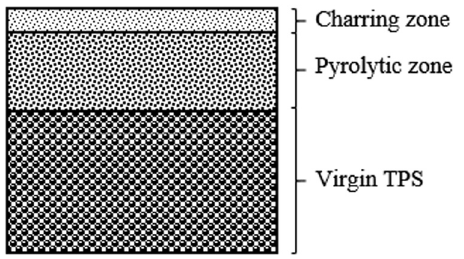
Figure 1: The three main regions formed during the ablation pro - cess [ 4 ] .